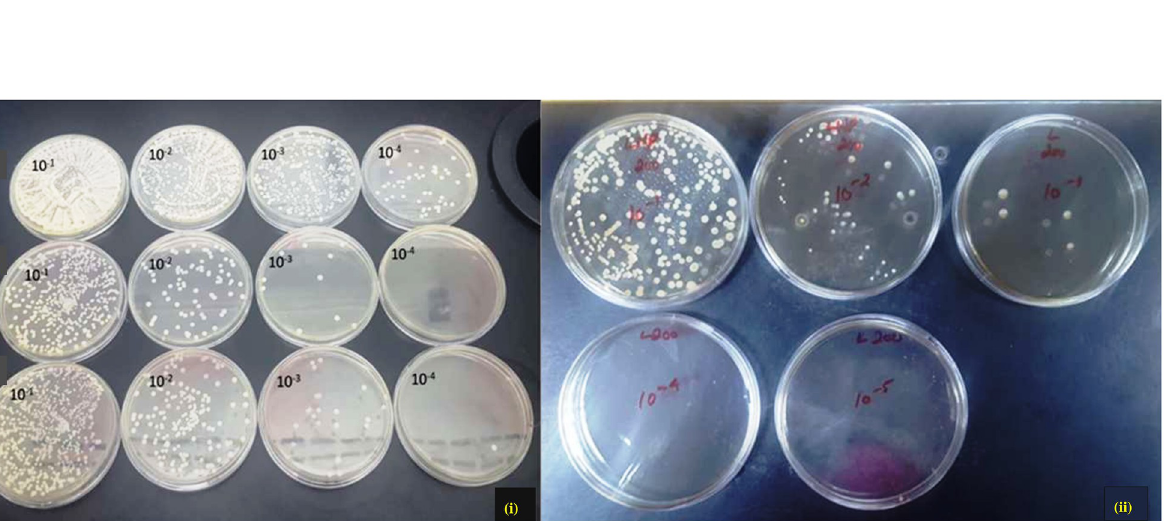
PLOS ONE | https://doi.org/10.1371/journal.pone.0273079 August 19,